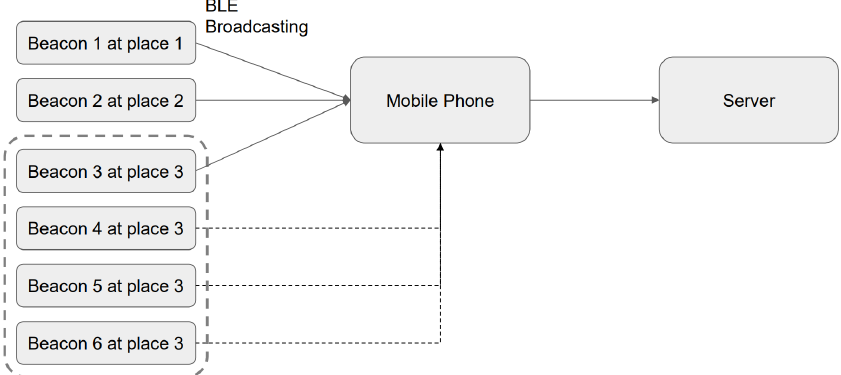
Figure 10. Obfuscation attack (faked Beacons 4, 5, and 6 and Beacon 3 under the original system are all placed at location place 3, sending obfuscation information to users).